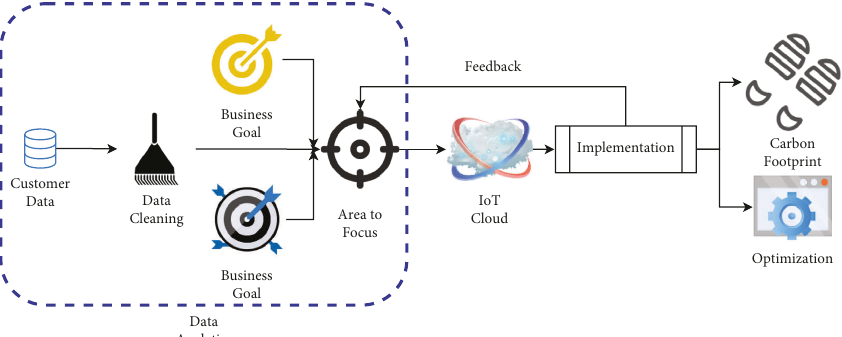
Figure 4: Data analytics for MPF inventory and carbon footprint.